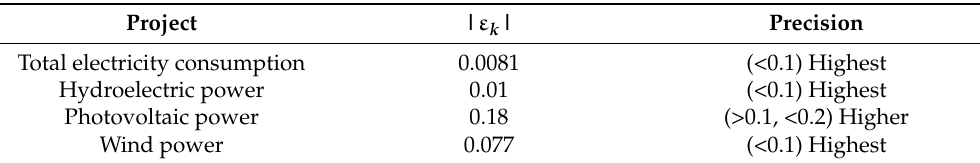
Table 5. China’s clean energy power generation forecast accuracy.